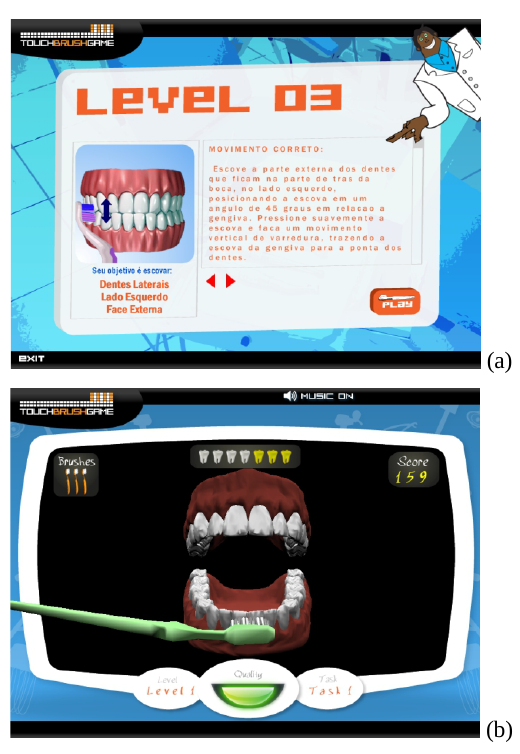
Fig. 9. Display with details of the task and game